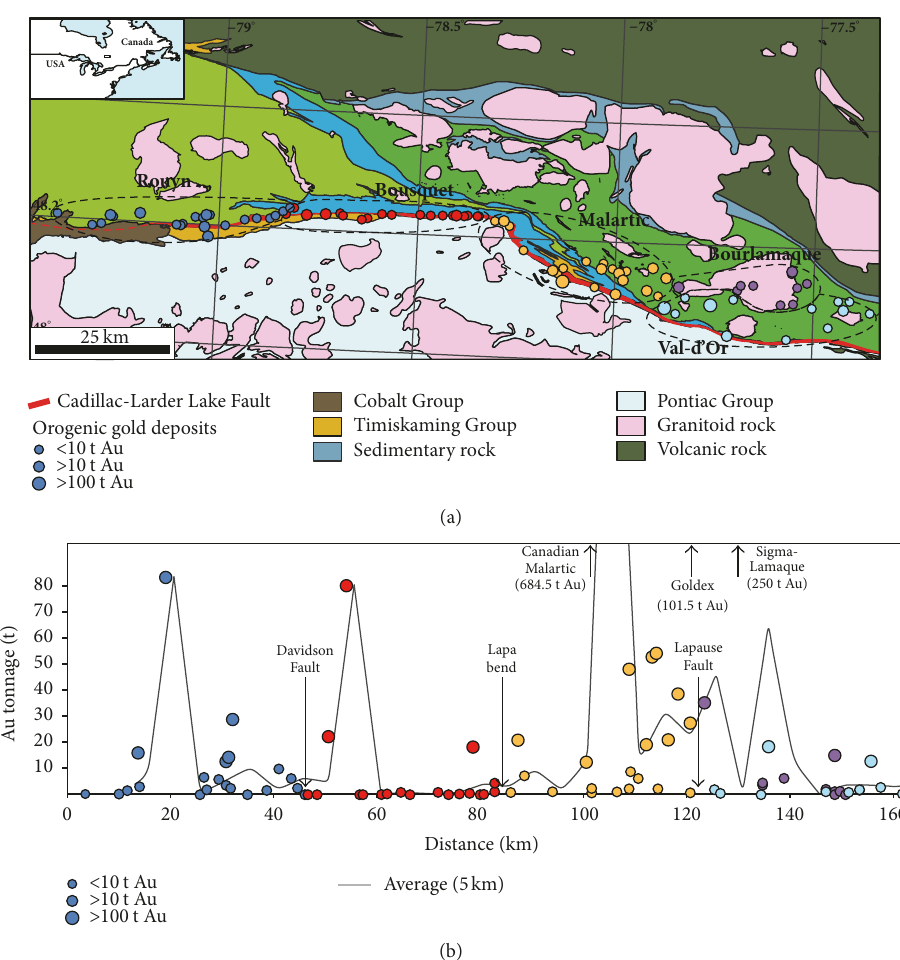
Figure 1: (a) Geological map of southern Abitibi showing the distribution of mesothermal gold deposits and goldfields. Colour of dots reflects the typology of deposits according to Rafini [30]. (b) Longitudinal distribution of gold deposits and goldfields with their respective tonnage.